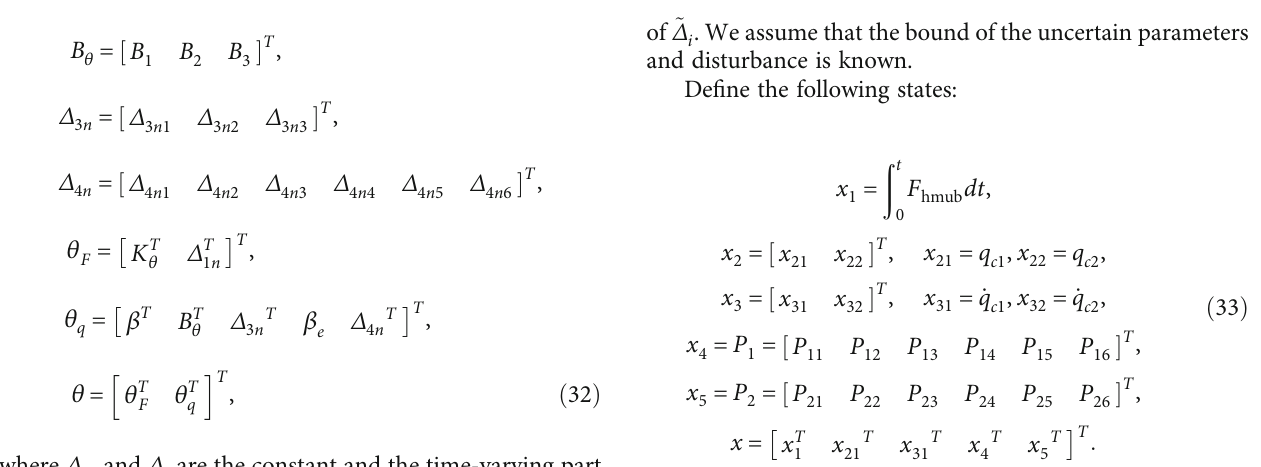
Figure 6: Simulation results of double leg support for Set1: (a) motion tracking error for left leg joints, (b) control input for left leg joints, (c) control input for right leg